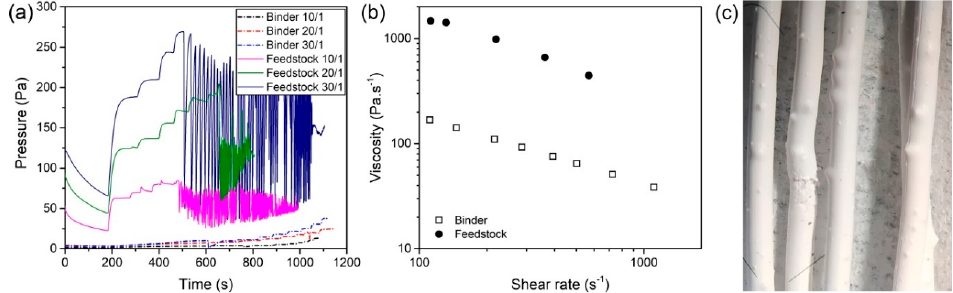
Figure 4. ( a ) Representative pressure curves measured for the binder and feedstock with the three nozzle geometries; ( b ) shear viscosity as a function of the shear rate for the binder and feedstock after applying the Bagley and Weissenberg–Rabinowitsch corrections; ( c ) feedstock rods collected during the rheological measurements.